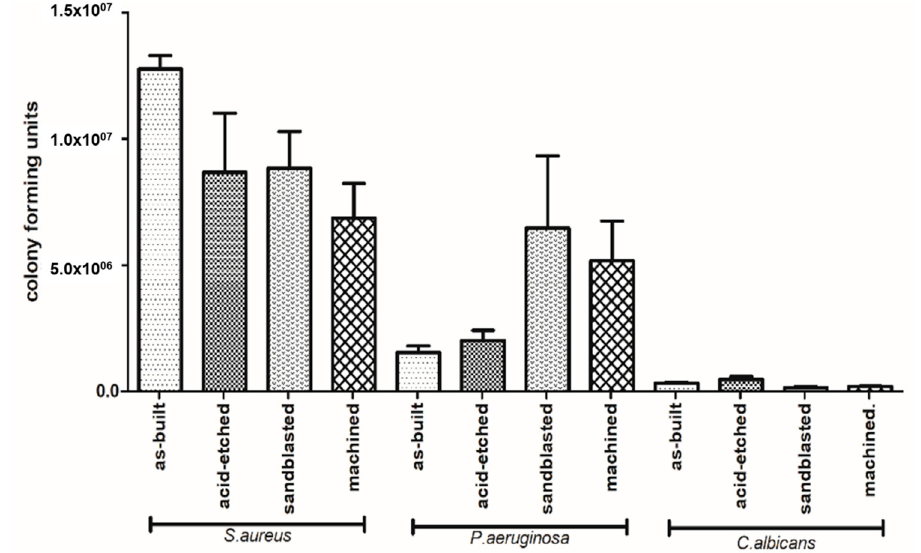
Figure 11. Di ff erences in number of microbial cells forming biofilm on particular types of samples (average values and standard deviation).